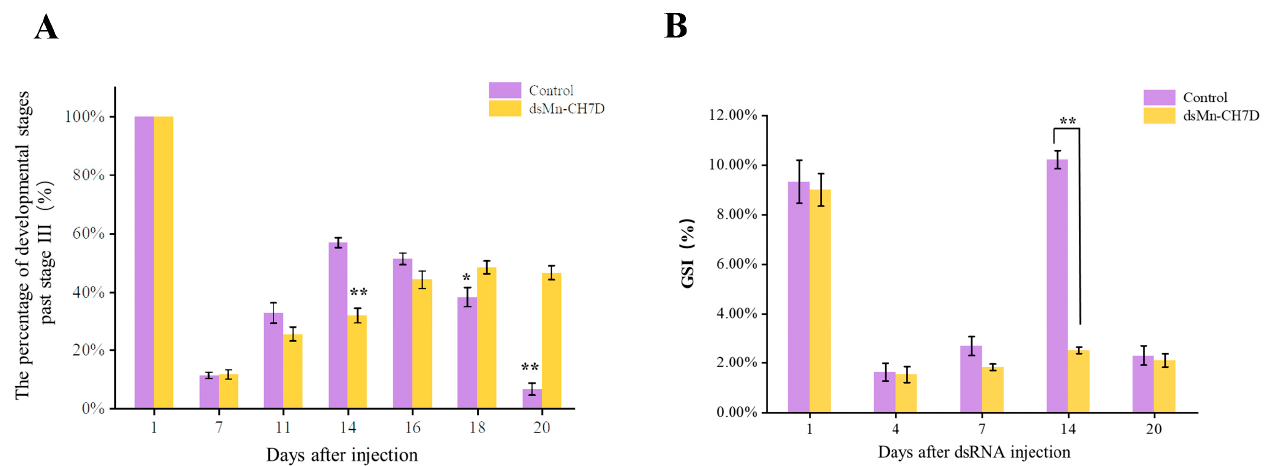
Figure 7. The percentage of development stages past stage III ( A ) and GSI (%) ( B ) of female Macro- brachium nipponense after injection with Mn-CH7D dsRNA. Data are shown as mean ± SD (n = 6). “*” indicates the significance of the differences ( p < 0.05). “**” indicates the significance of the differences ( p < 0.01).